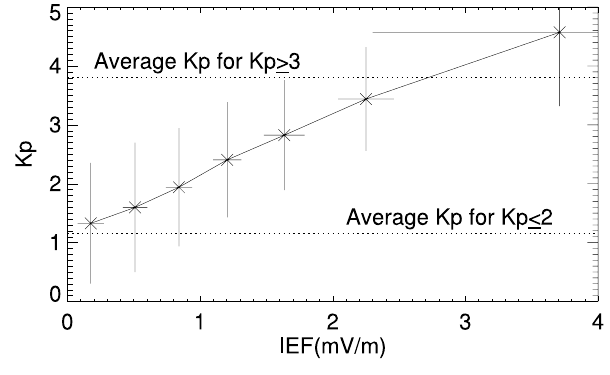
Fig. 3. The relation between IEF and K p index. Average K p values for each IEF range are calculated together with standard deviations shown by error bars. The average K p values for K p ≤ 2 and K p ≥ 3 are also indicated by dotted